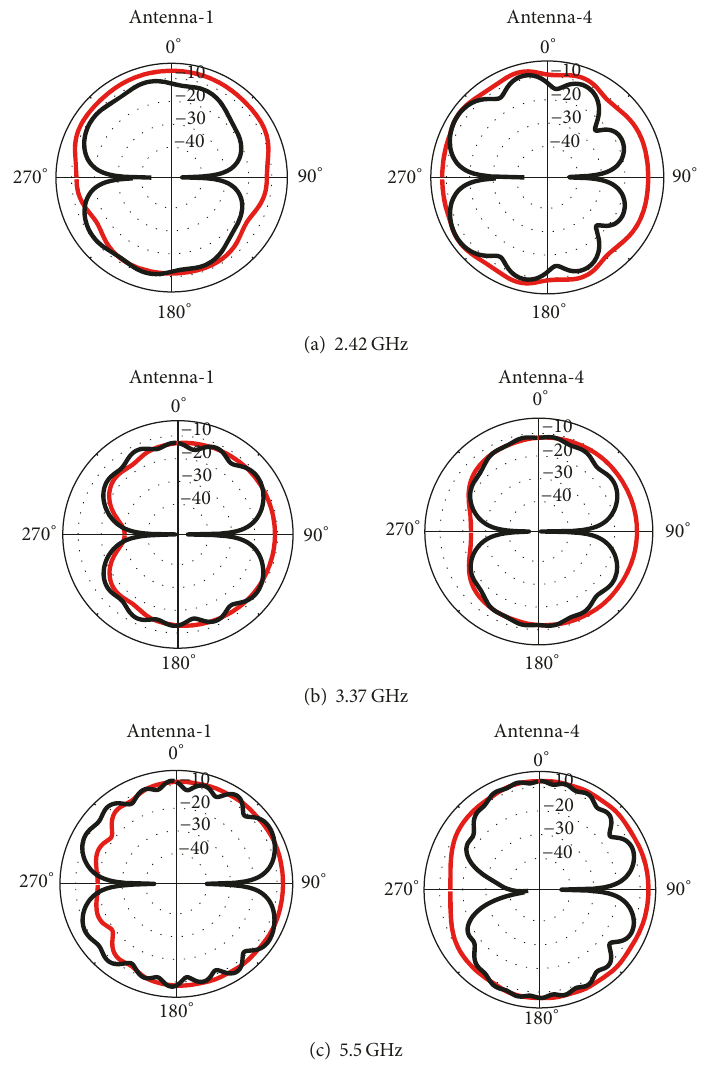
Figure 13: Measured radiation pattern of the proposed MIMO antenna. Table 2: Comparison of simulated and measured values of gain and efficiency of the proposed antenna array (case III). Gain (dBi) Efficiency (%) Covered bands (GHz) Simulated Measured Simulated Measured 𝑓 𝑙 4.61-5.25 4.42-4.90 𝑓